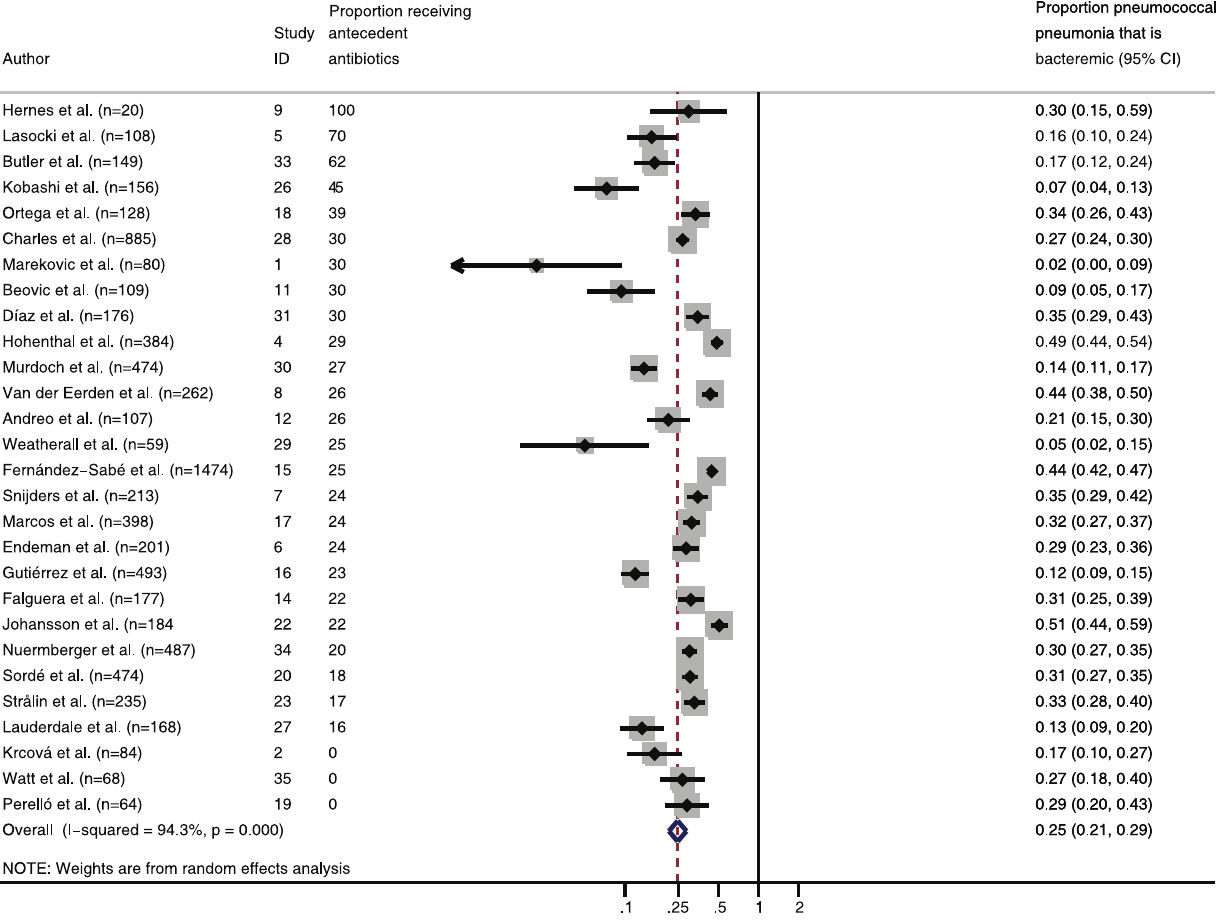
Figure 4. Forest plot for the proportion of pneumococcal pneumonia identified as bacteremic, sorted by proportion of study participants who received antecedent antibiotics.